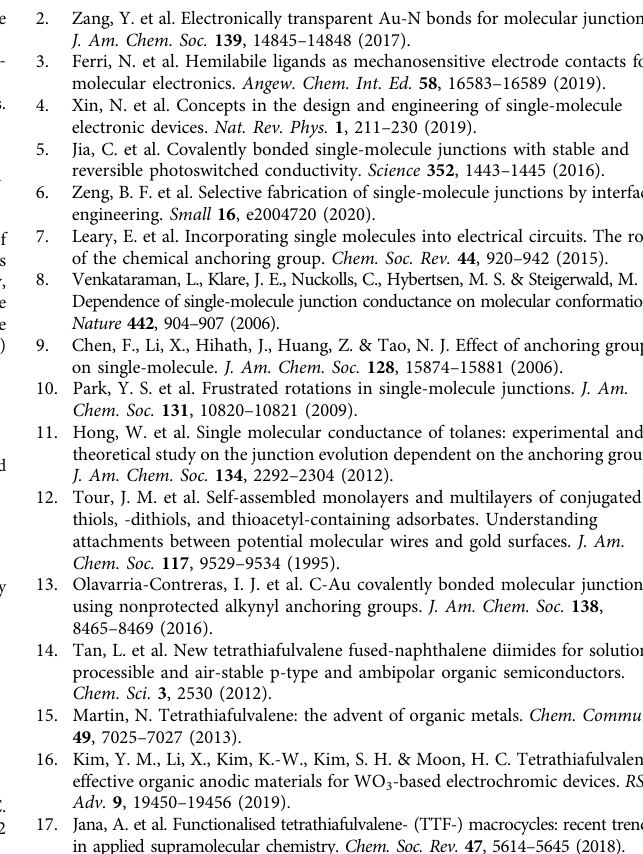
Fig. 5 Mechanically controlled switching measurements. a Schematics of the single-NDITTF-SHe molecule junctions formed during the STM tip-substrate displacement modulation. b Piezo displacement as a function of time (top) and 2D conductance-time histograms obtained during displacement modulations. The 2D histogram is constructed from 733 traces selected out of total 20,000 traces. c Line pro fi les comparing the conductance in different